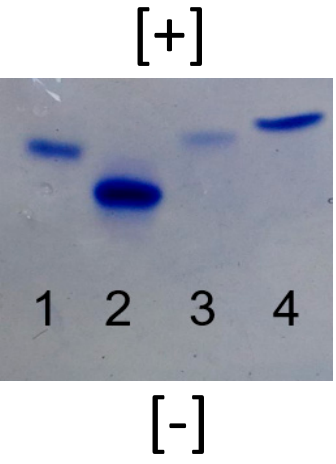
Figure 4. Acidic native PAGE of the nanomolecule. Lane 1 is the mixed-surface G4 dendrimer with 30% surface amines and 70% surface hydroxyl groups, lane 2 is the G4 pure-amine surface dendrimer, lane 3 is the mixed-surface G4 dendrimer with 10% surface amines and 90% surface hydroxyl groups, and lane 4 is the G4 pure hydroxyl surface dendrimer. All dendrimers are at 5 µg/lane.